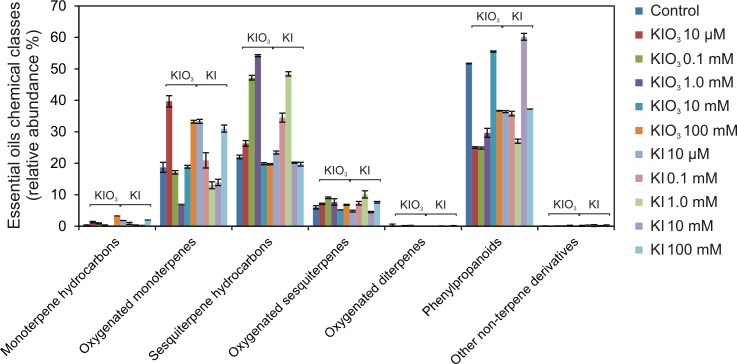
Essential oil composition of basil plants cultivated in growth chamber.The behavior of the chemical classes of the volatile organic compounds was detected in the compositions of leaf essential oils extracted from basil plants treated with KI or KIO3 (0; 10 μM; 0.1 mM; 1 mM; 10 mM; 100 mM).